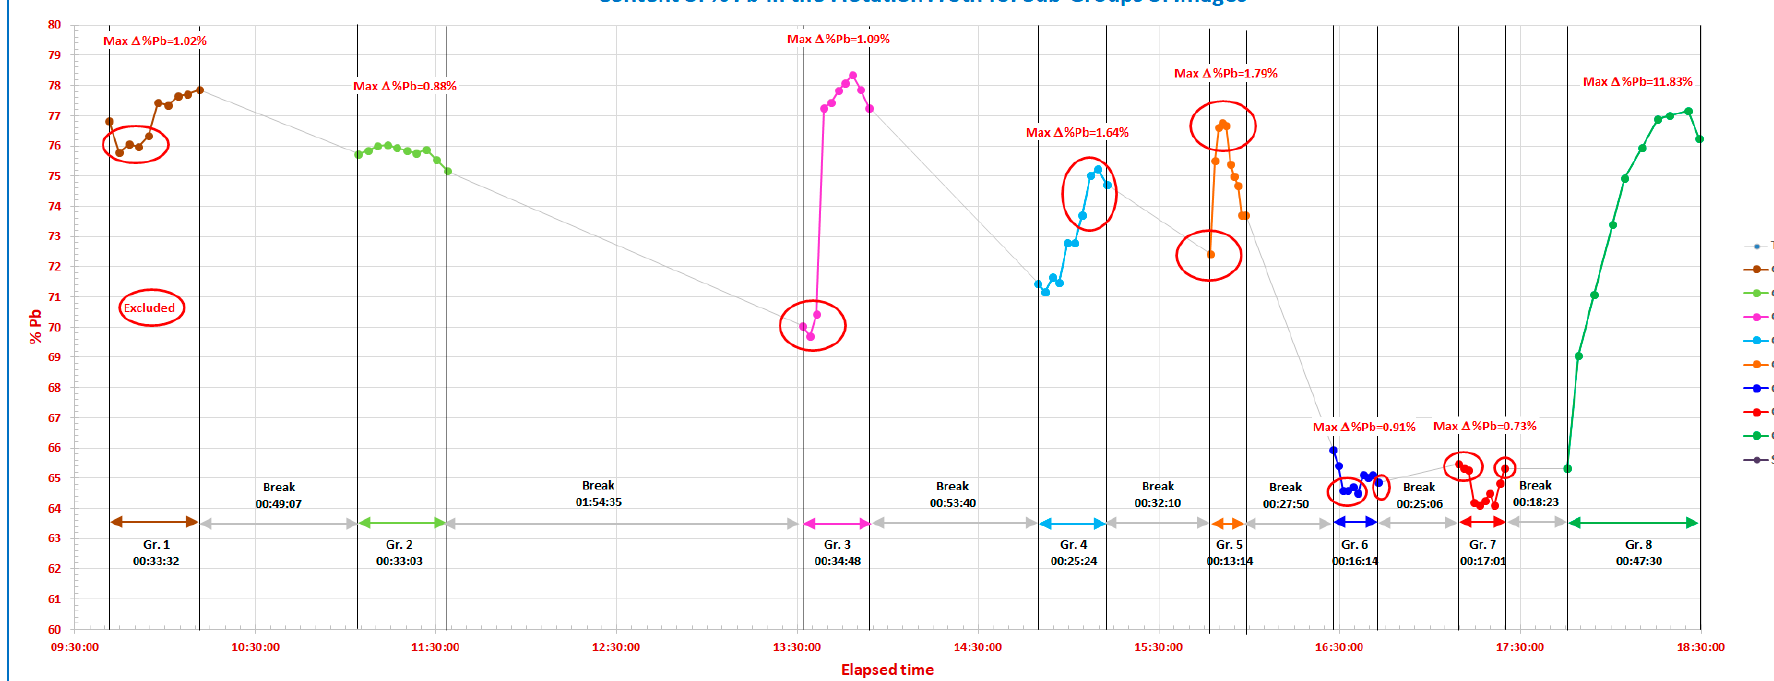
Figure 4. Content of %Pb versus time in the flotation froth.